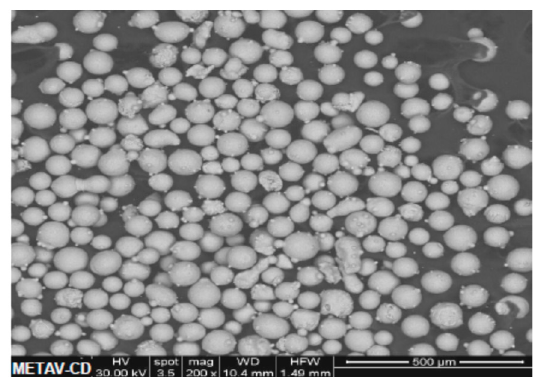
Figure 4. SEM of gas atomized 20Cr10Al2Y complex powders.